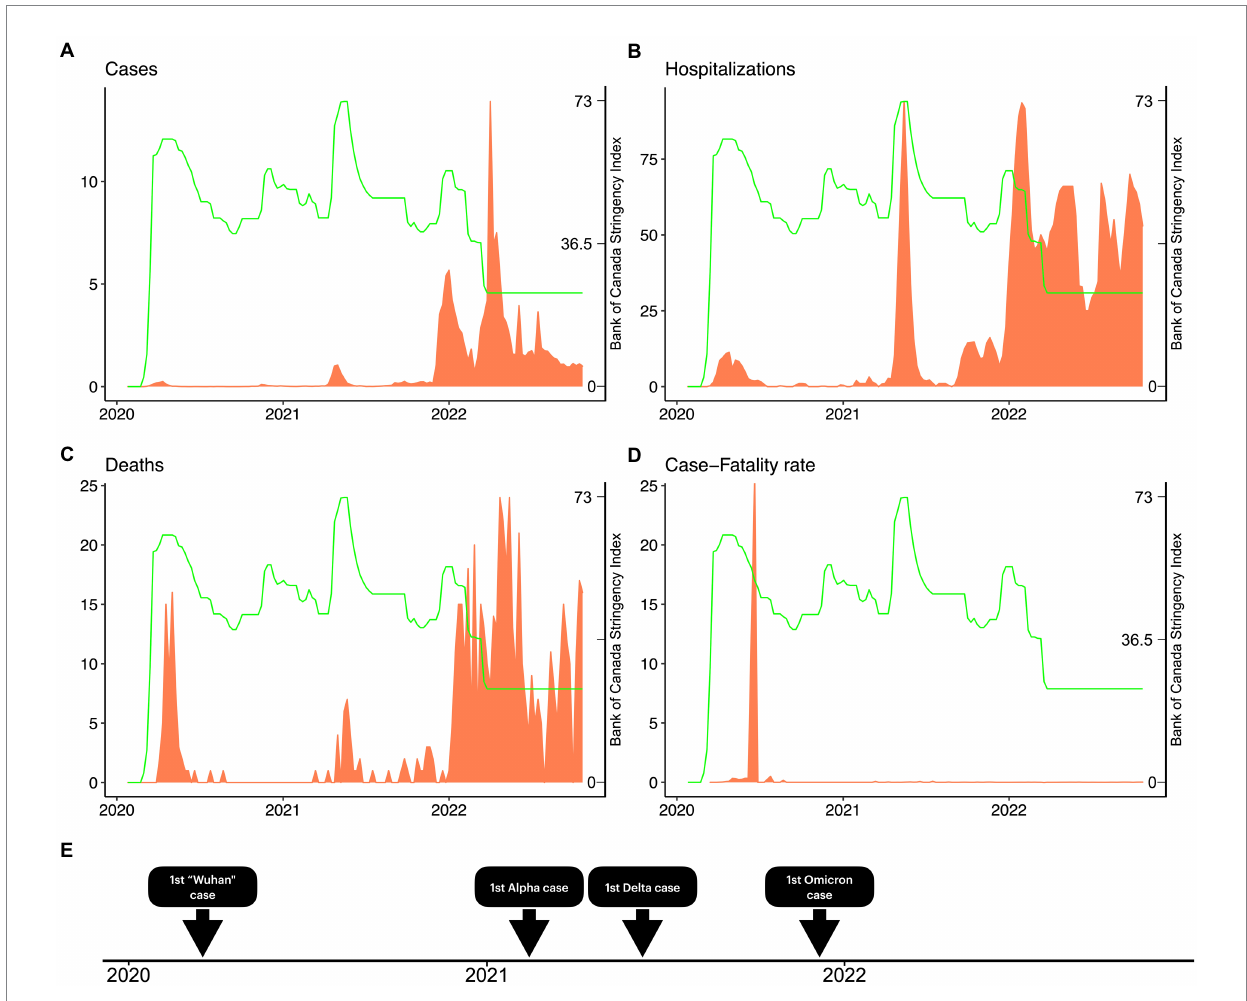
FIGURE 4 COVID-19 cases, hospitalizations, fatalities, case-fatality ratio, and the Stringency Index in Nova Scotia. We demonstrate the weekly evolution of Bank of Canada Stringency Index (green) throughout the pandemic in Nova Scotia. We also overlay the Stringency Index with the weekly number of